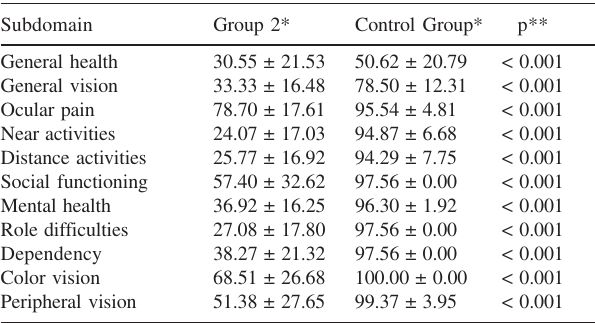
Table 4 - Comparison of the NEI VFQ – 25 subdomain scores based on the responses of patients with age-related macular degeneration and legal binocular (group 2) blindness and the control group at the University of Sao Paulo General Hospital in 2006